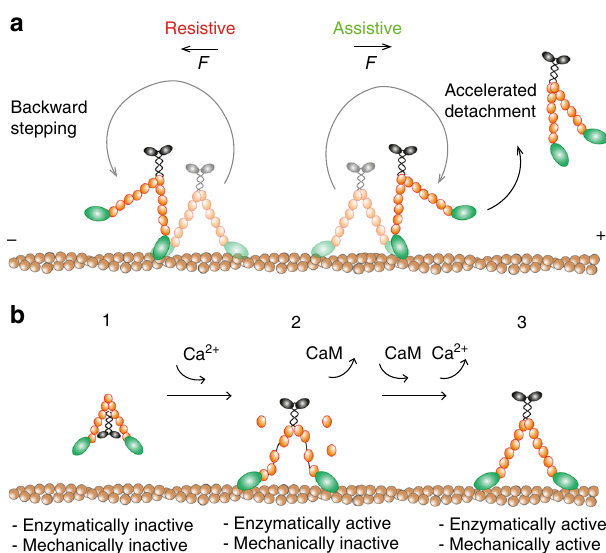
Fig. 7 Proposed model of myosin-5B regulation by force and Ca 2 + . a In the presence of assistive forces, myosin-5B moves in the direction of the force at full speed by consecutive steps towards the plus actin end. However, assistive forces drastically reduce myosin run length as a consequence of accelerated detachment of the motor from actin. On the other hand, resistive forces slow down the motor and reduce its run length as a consequence of increased back stepping. b (1) In the absence of Ca 2 + , myosin-5B folds in an enzymatically and mechanically inactive conformation where head-tail interaction hinders binding to actin. (2) As Ca 2 + concentration increases, myosin-5B switches to an open conformation that can bind to actin, thus becoming enzymatically active. However, Ca 2 + -induced detachment of 25% of CaM molecules results in loss of myosin processivity. (3) In the presence of excess CaM (2 – 5 μ M), new CaM molecules are available for occupying the vacant binding sites on the light chains, thus restoring myosin capability to move along